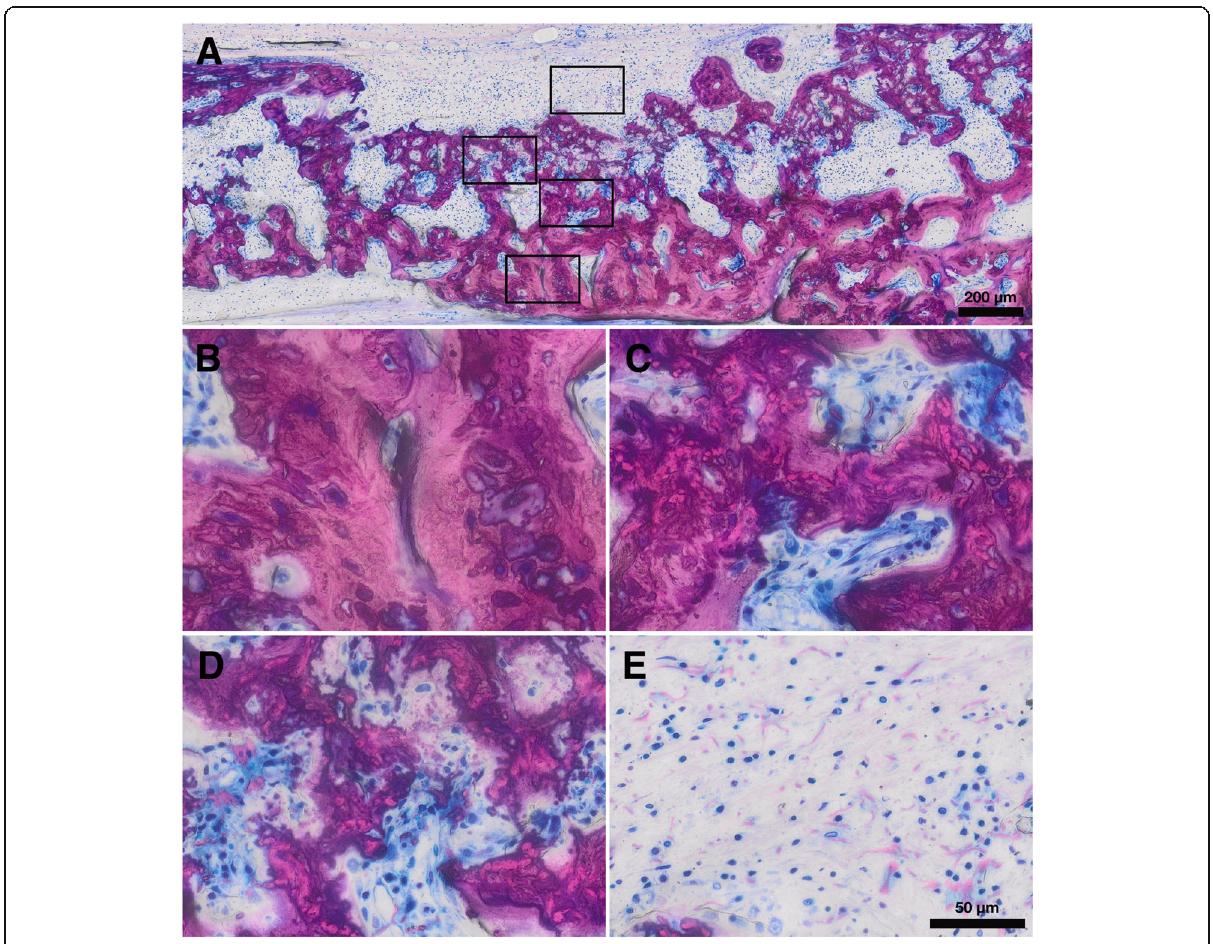
Fig. 4 Histological overview of a defect treated with a regular membrane. a, b Bone with collagen. c, d Bone without collagen. e, f Mineralized collagen